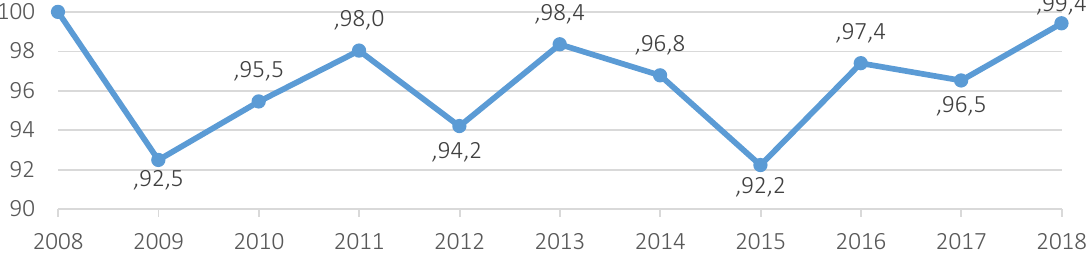
Figure 2. Index of physical volume of GRP in Odesa region in 2008–2018, percent (2008 = 100 %)